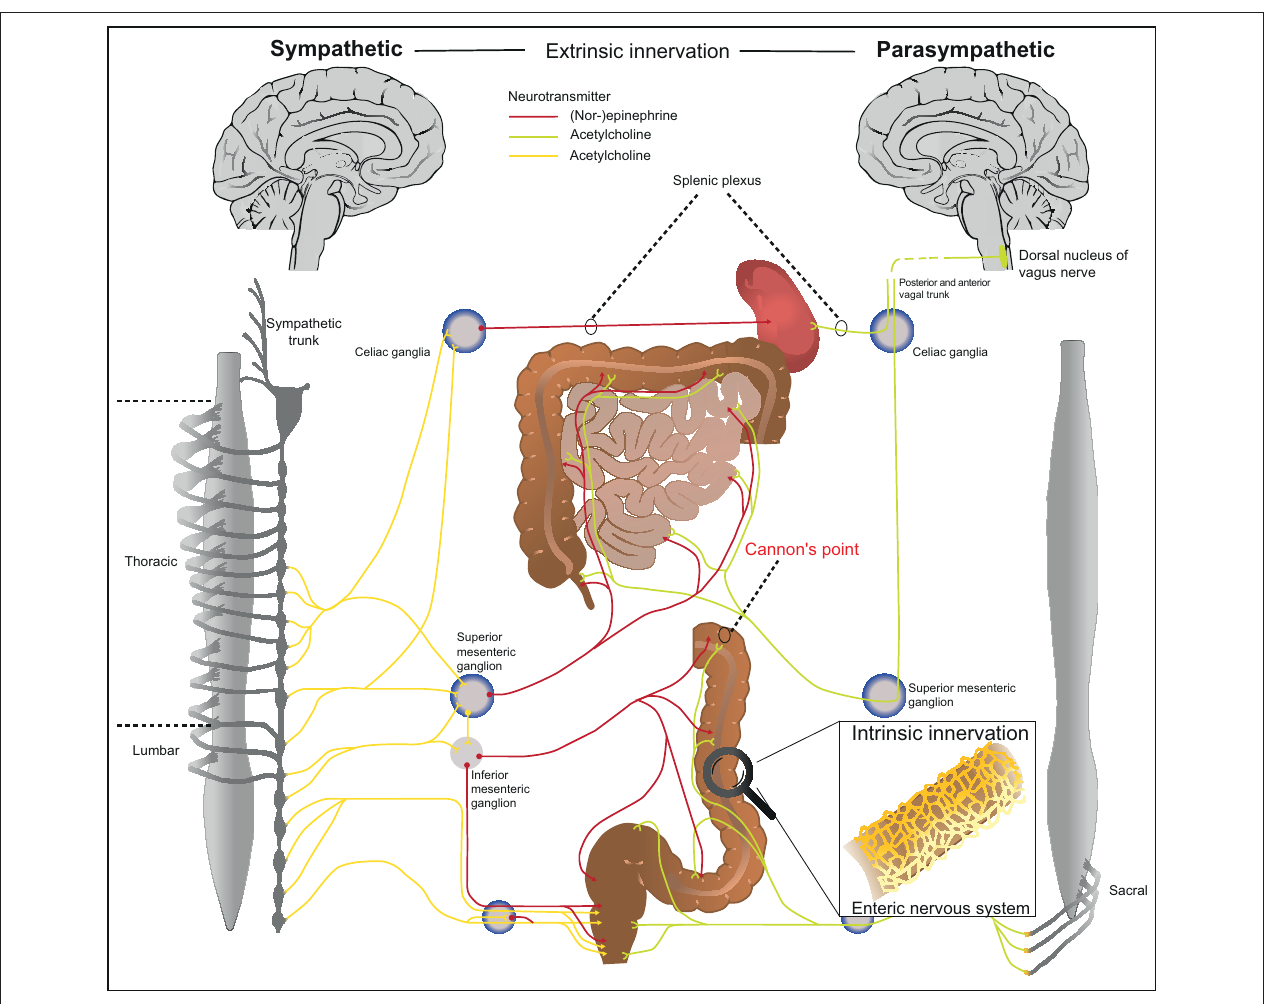
FIGURE 1 | Anatomical organization of the autonomous nervous system. The autonomous nervous system is organized in three anatomical and biochemical distinct systems. (1) The sympathetic nervous system has its preganglionic cell bodies in the thoraco-lumbar region (sympathetic trunk). The pregangliotic sympathetic neurons synapses with the postgangionic neuron in the sympathetic trunk, whereas the long postganglionic neuron (red) innervates the respective part of the gastro-intestinal tract. (2) The cell bodies of the parasympathetic nervous system are located in the brainstem and the pelvic sacral nerves. The vagal nerve includes preganglionic fibers from parasympathetic nervous system (green) that innervates the gastro-intestinal tract and ends just before the splenic flexure of the transverse colon (also known as Cannon’s point). After Cannon’s point, the colon is innervated by the pelvic sacral plexus. The postganglionic neuron is localized in immediate proximity to the target organ. (3) The enteric nervous system is located within intestinal tissues (Auerbach plexus, Meissner plexus) and has a characteristic architecture (details see Figure 2 ).